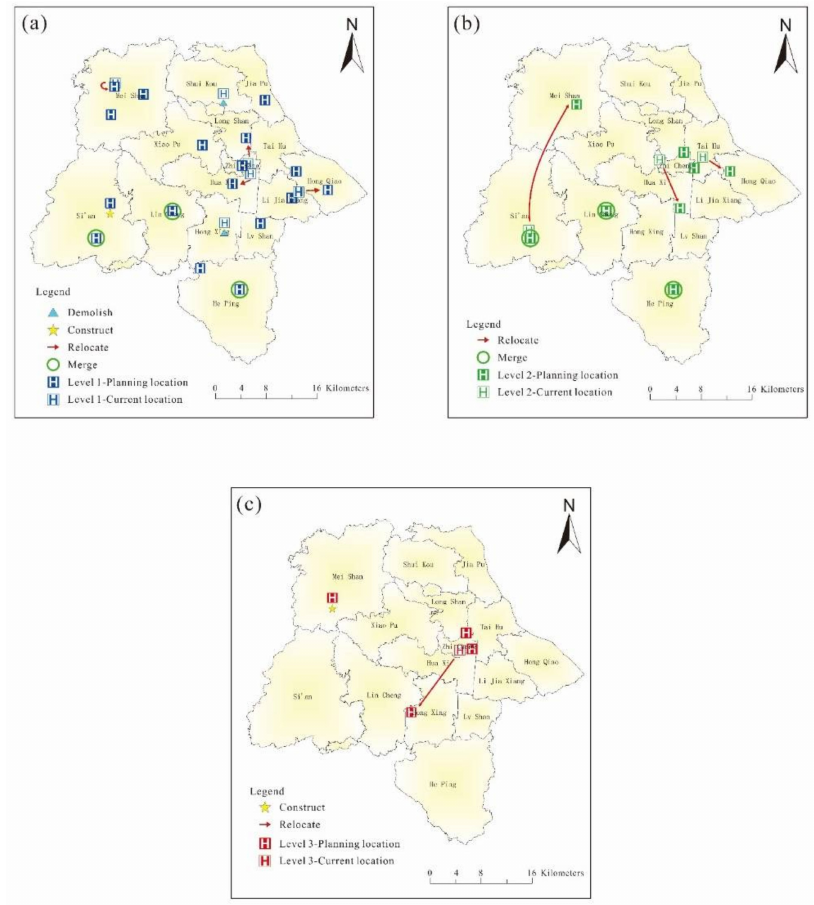
Figure 5. ( a – c ) Changes in the locations of medical